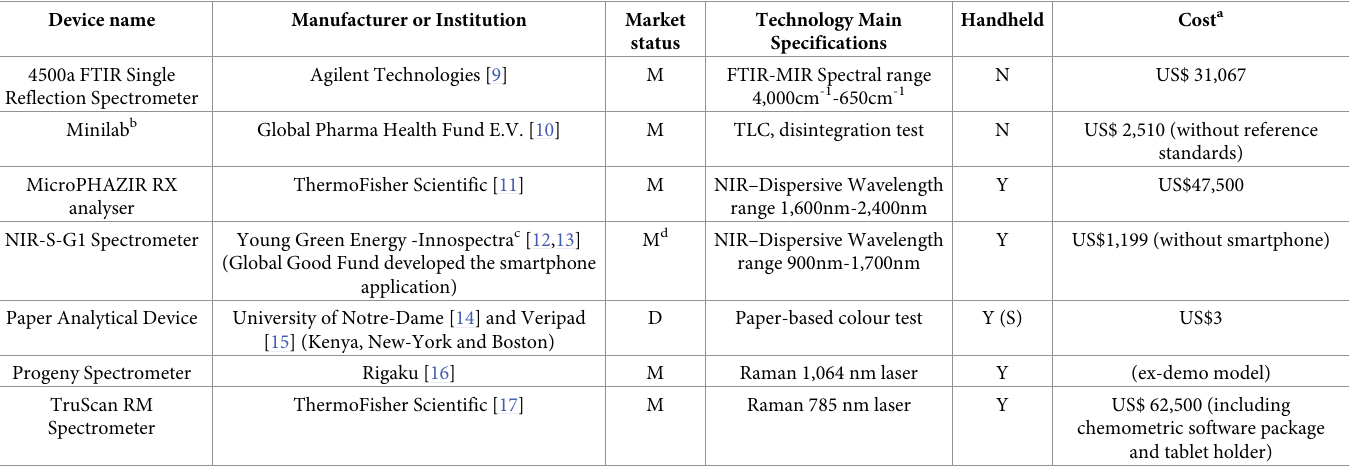
Table 1. Main characteristics of the devices included in the study �